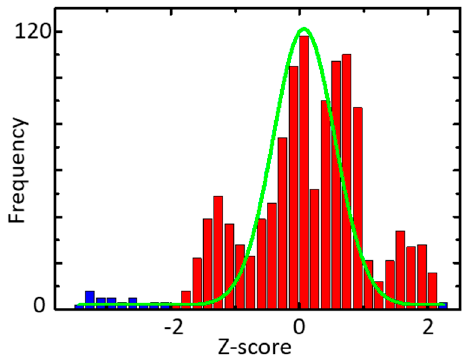
Figure 6. Histogram example of Z- score in COSTANT. Micromachines 2020 , 11 , x